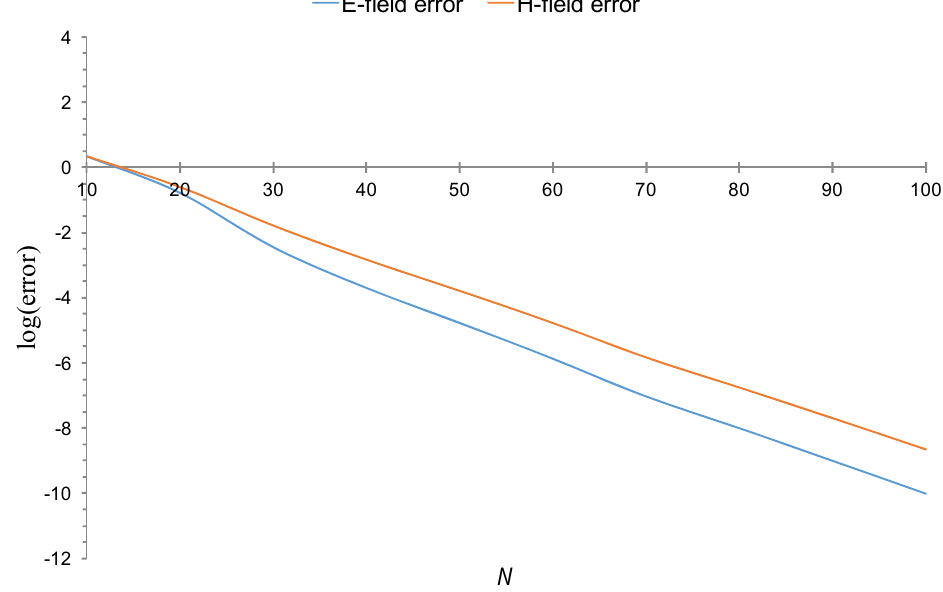
Figure 4. Logarithm (with base 10) of the computed peak (max) electric-field and magnetic-field boundary-condition errors as a function of the number of auxiliary sources in each set of sources inside/outside each cylinder for a 1 × 5 lattice of cylinders. The parameters pertaining to the cylinders and the incident field are provided in Table 1.